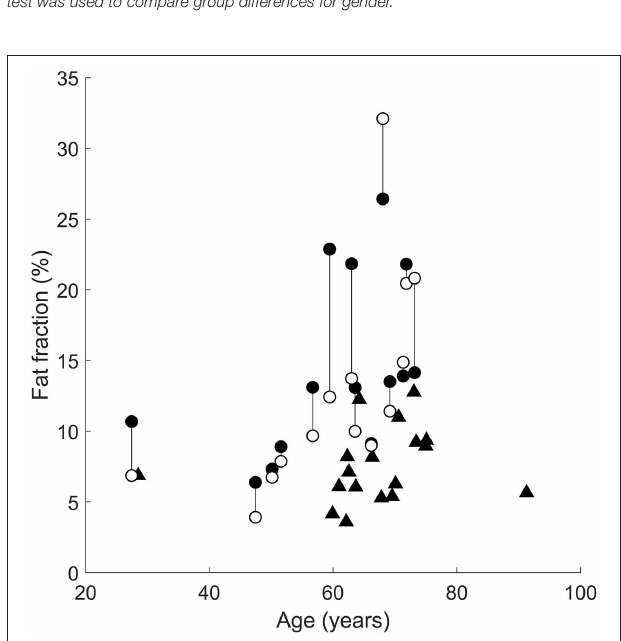
FIGURE 3 | Intramuscular fat fractions in the paretic (filled circles), non-paretic (open circles), and control (triangles) medial gastrocnemius muscles. Vertical lines join paretic and non-paretic muscles from individual stroke